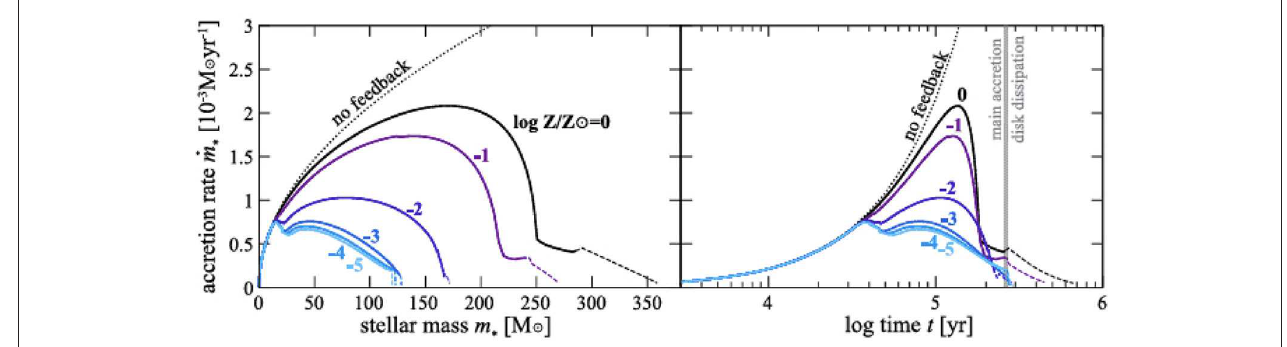
FIGURE 13 | The role of magnetized outflows in massive star formation as a function of metallicity. Accretion histories as functions of protostellar mass, m ⋆ (Left) and time, t (Right) for stars forming from cores with initial masses of M c =1000M Z/Z = -5, -4, -3, -2, -1, and 0 are shown as labeled. For each line, the solid part represents the main accretion phase and the dashed part is the disk dissipation ⊙ phase (the gray vertical line in the right panel indicates the transition time). The black dotted lines show the no-feedback case. The accretion rate is lower at lower metallicity due to stronger total feedback. From Tanaka et al. (2018) reproduced with permission c